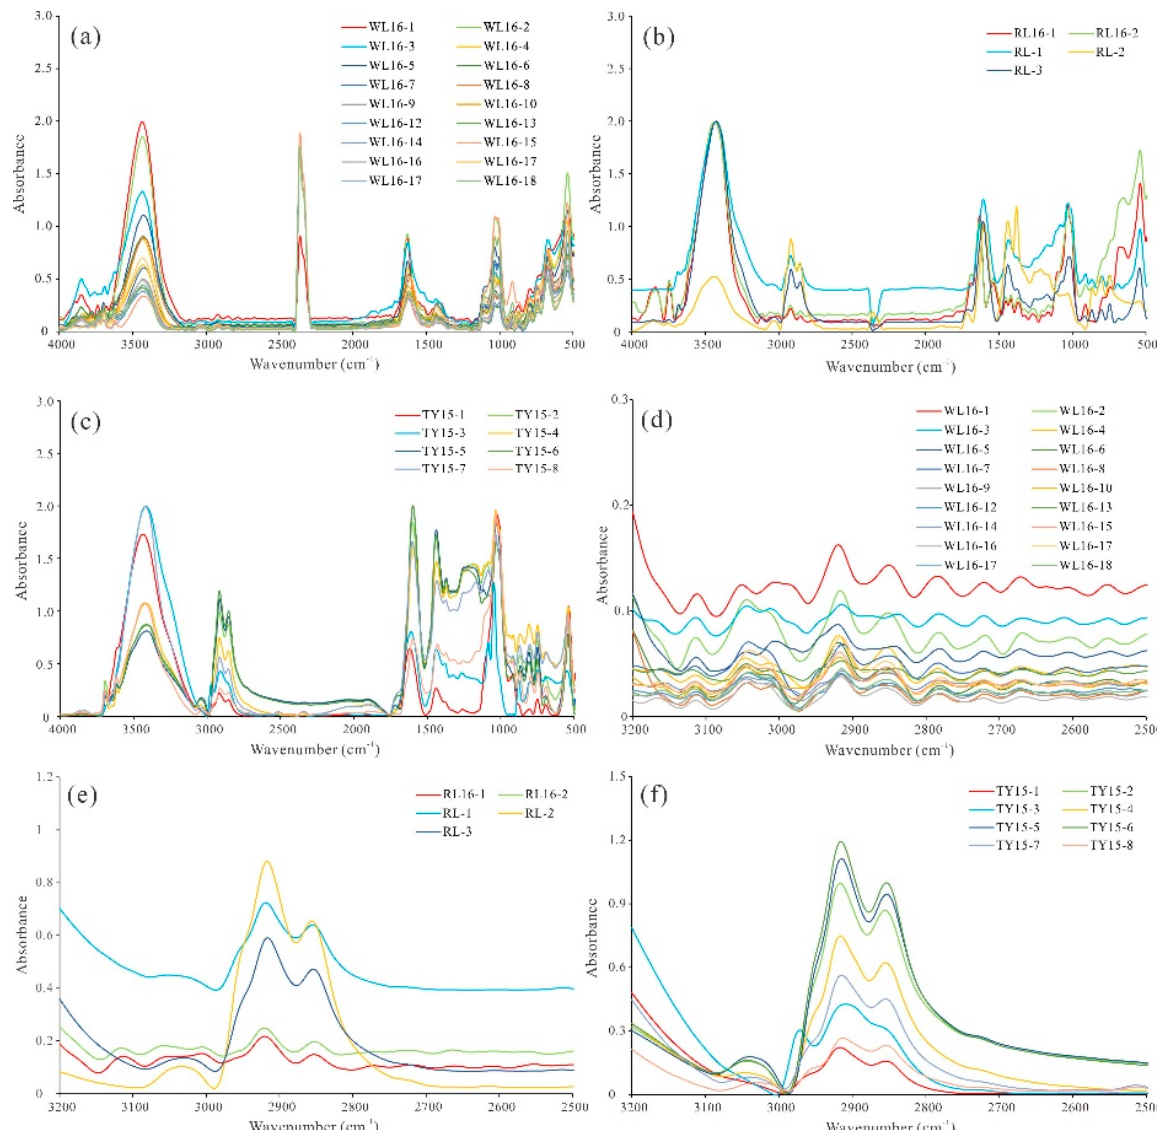
Figure 5. Infrared spectrum curves at wavenumbers of 500–4000 cm − 1 ( a – c ) and 2500–3200 cm − 1 ( d – f ) of all the selected coal samples from the Wolonghu, Taoyuan and Renlou coal mines in the Huaibei Coalfield.